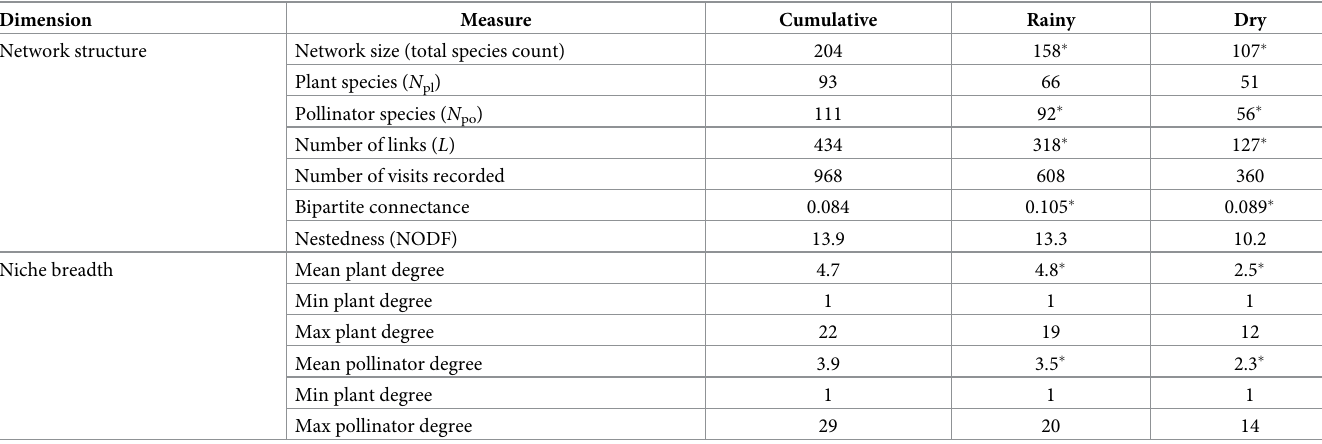
Table 1. Seasonal changes in network structure and species niche breath in a plant-pollinator community from the Cerrado. Dimension Measure Cumulative Rainy Dry Network structure Network size (total species count)